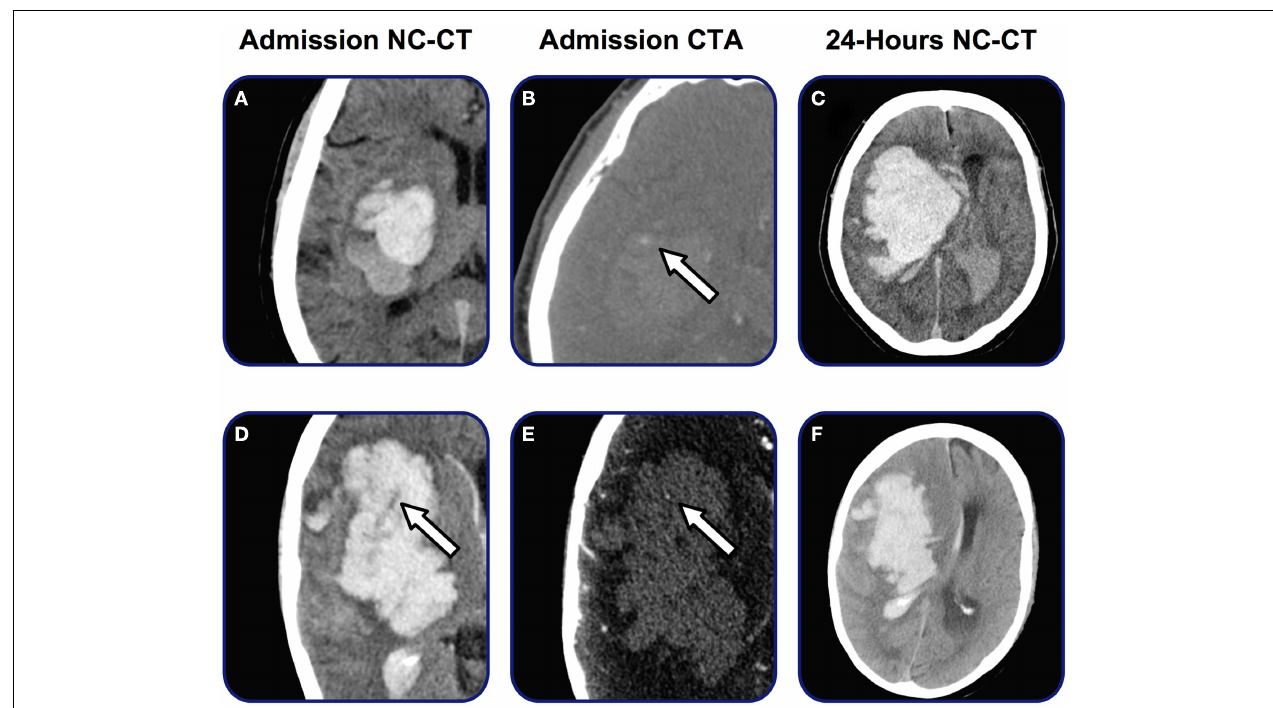
FIGURE 5 | Heterogenicity on admission NC-CT . Admission and follow-up radiology on two patients admitted with acute ICH. NC-CT (A,D) demonstrates marked heterogenic attenuation in hematoma appearance. Arrow on (D) marks swirl-sign. On (B,E) both patients present spot sign. After 24h (C,F) both patients present enlargement of the hematoma volume and midline